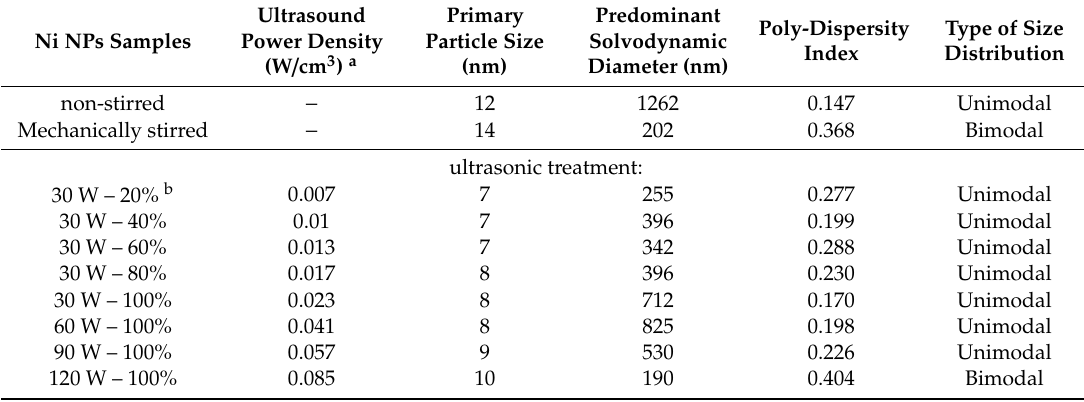
Table 1. Acoustic energy, particle and dispersion dimensions of the nickel nanoparticles prepared at 25 ◦